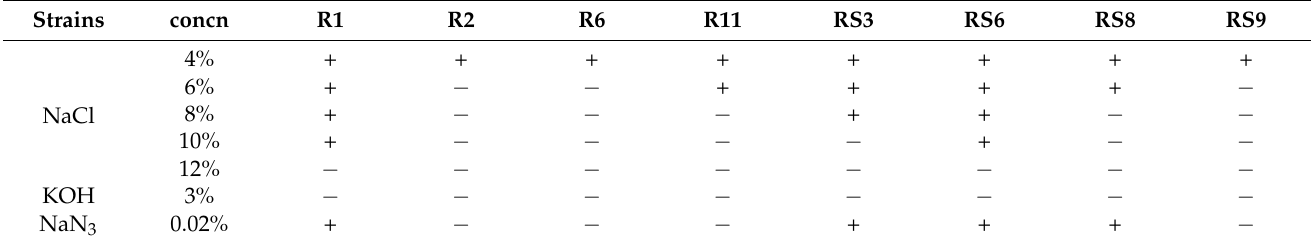
Table 5. Response of endophytic bacterial strains against salinity and chemical